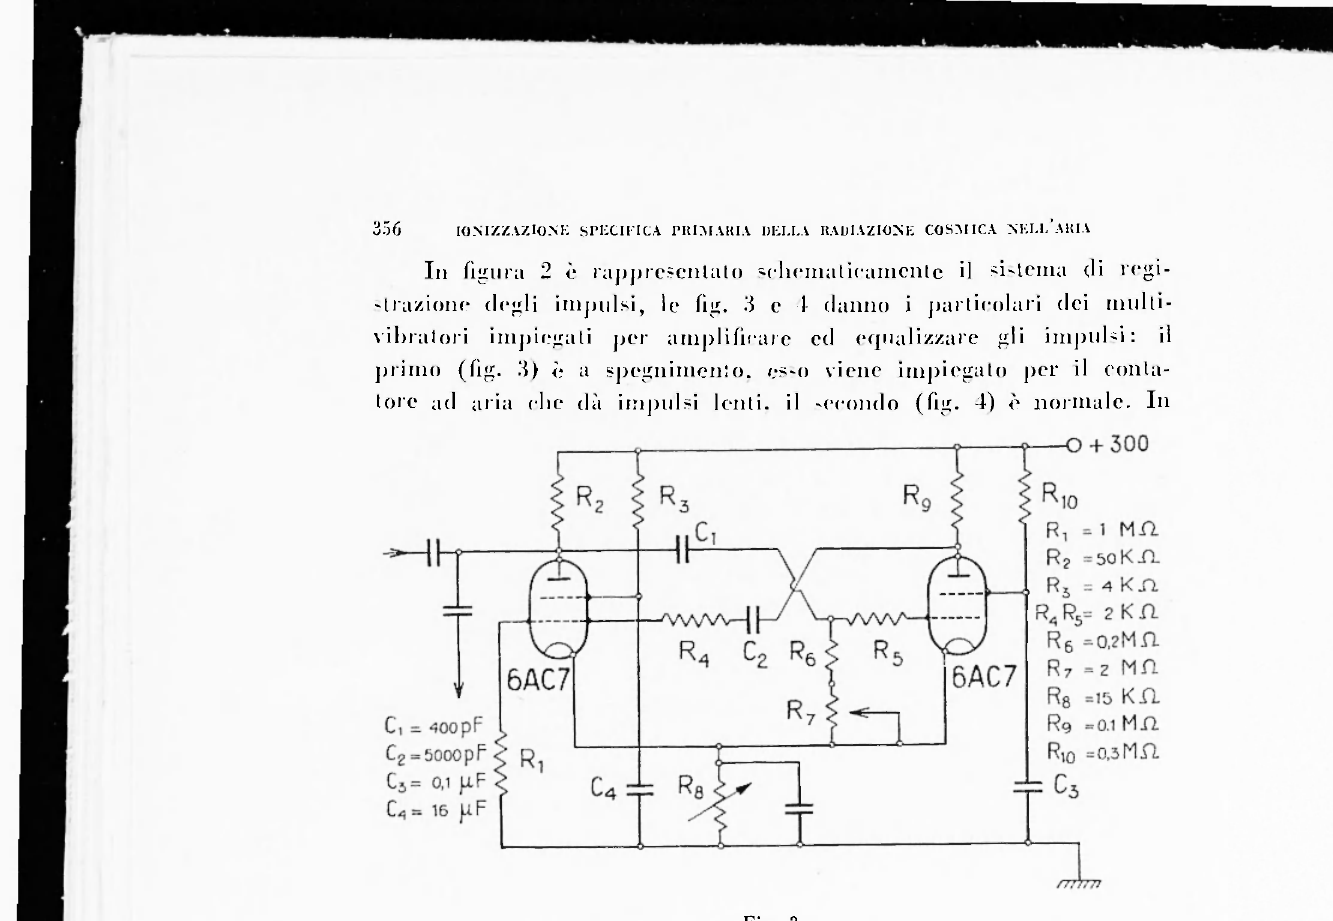
fig. 5 è riportato lo schema di una comune coincidenza alla